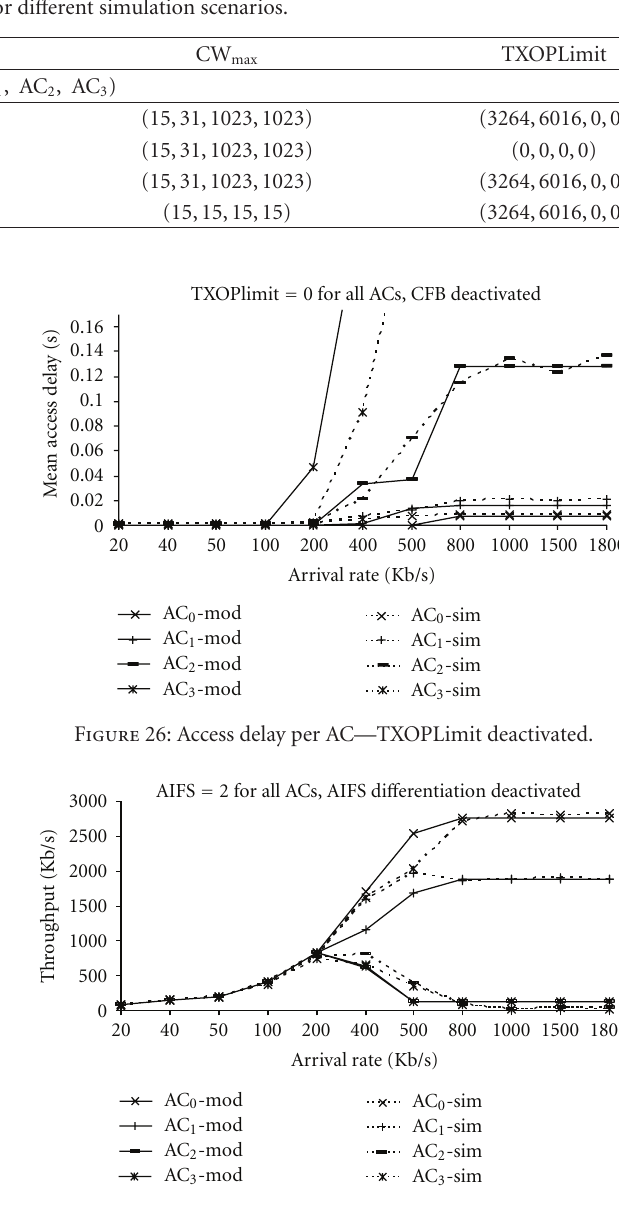
Figure 27: Achievable throughput per AC—AIFS